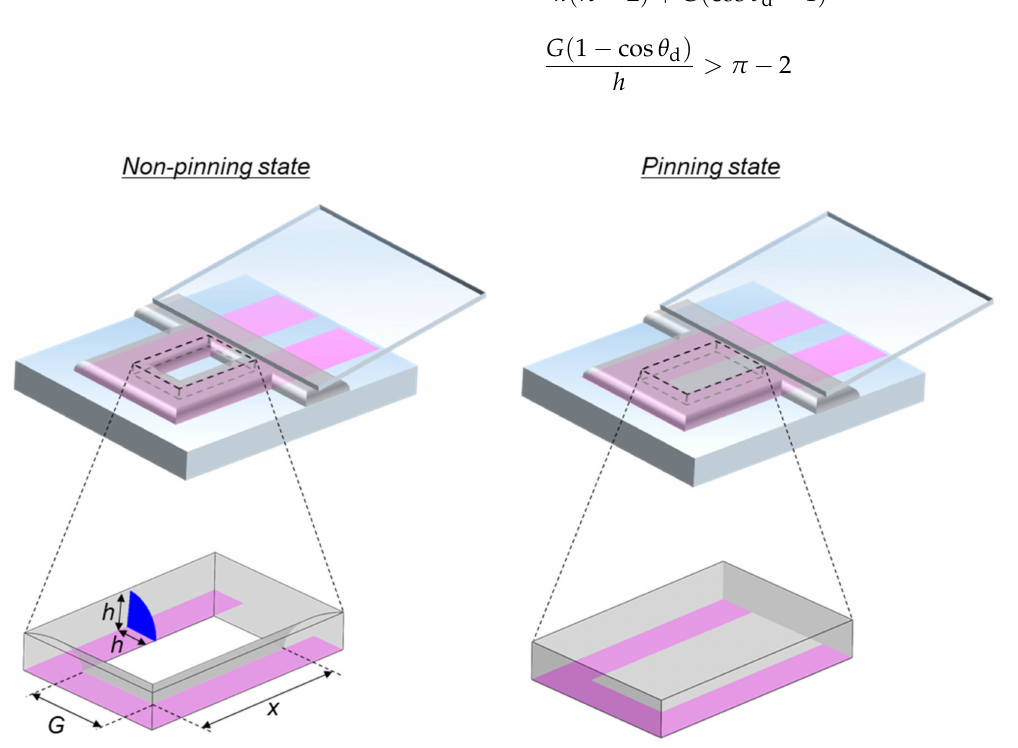
Figure 3. Schematic models of non-pinning and pinning states used for the interfacial free-energy